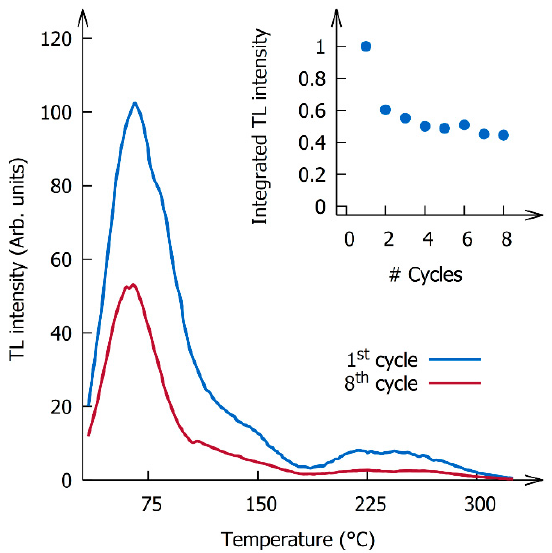
Figure 2. Thermoluminescence glow curves recorded after 600 s of X-ray irradiation (~150 Gy). The inset shows the total integrated thermoluminescence intensity as a function of the number of charging–heating cycles.